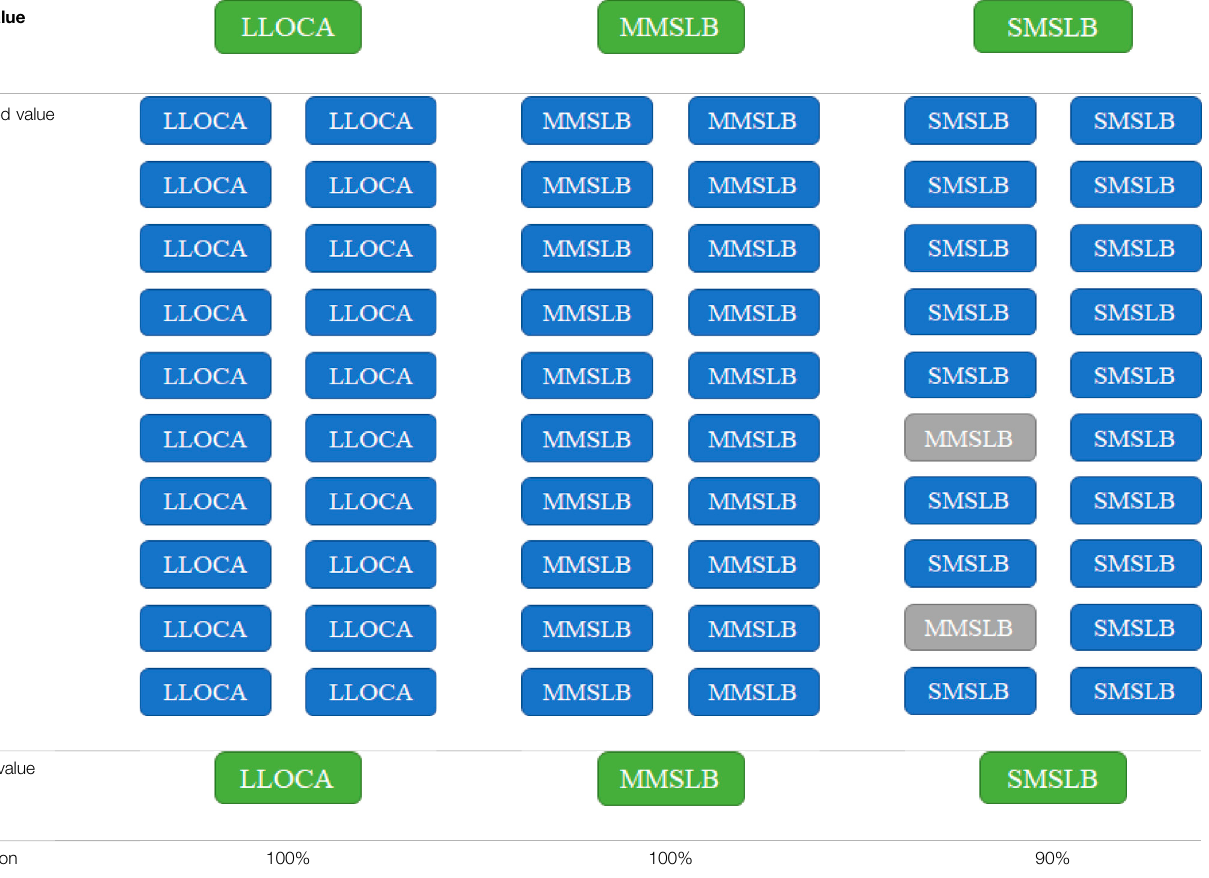
TABLE 8 | Partial samples of correct